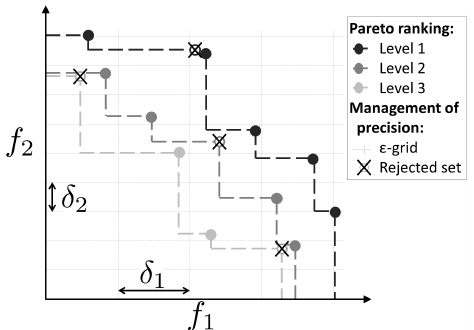
Figure 4. Method for population downsizing for a maximization problem with two objectives: Pareto ranking (level 1 is the current approximated Pareto front) and partition of the objective space ac- cording to the chosen δ i precision (only one vector by hypercube is